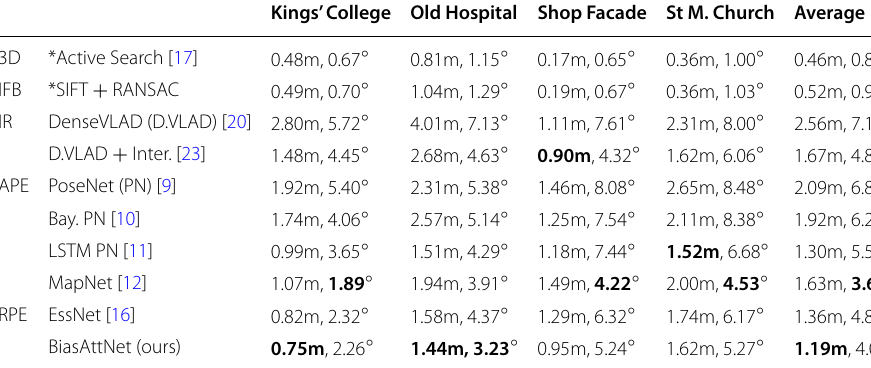
We compare our approach against 3D structure-based method (3D), image retrieval (IR), indirect feature-based localization (IFB), absolute and relative pose estimation (APE and RPE) methods. We report the median position error in meters and orientation error in degrees. The best results are highlighted in bold except for methods marked with a